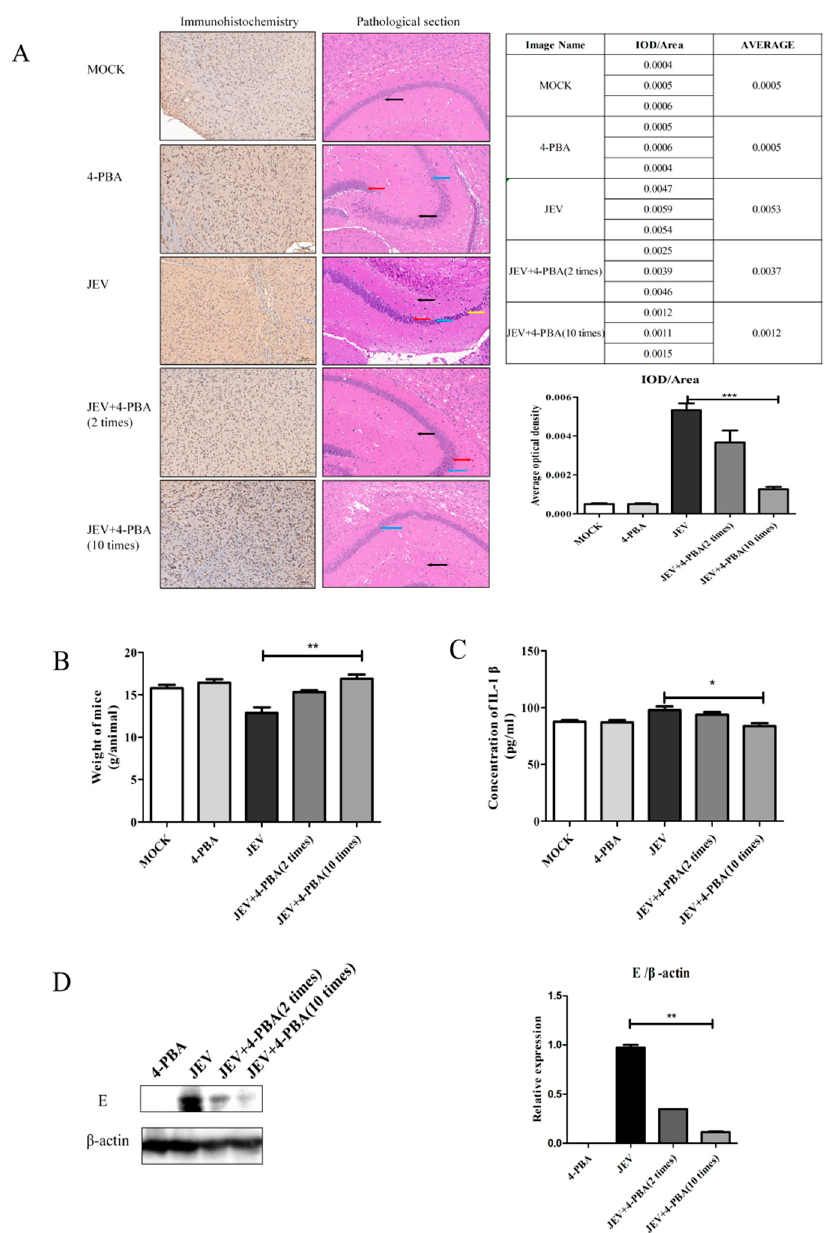
Figure 2. Therapeutic effect of 4-PBA in JEV-infected mice. ( A ) Detection of virus particles in brain tissues by immunohistochemistry and pathological analysis on sagittal plane of brain tissue. ( B ) Weight changes in mice infected with JEV and treated with 4-PBA. ( C ) Detection of IL-1 β in serum. ( D ) Detection of virus particles in brain tissues by western blot. Yellow arrow: neurons disappear; blue arrow: a large number of nerve cells degenerate; red arrow: nerve fiber tangle; black arrow: glial cell. * p < 0.05; ** p < 0.01; *** p < 0.001.